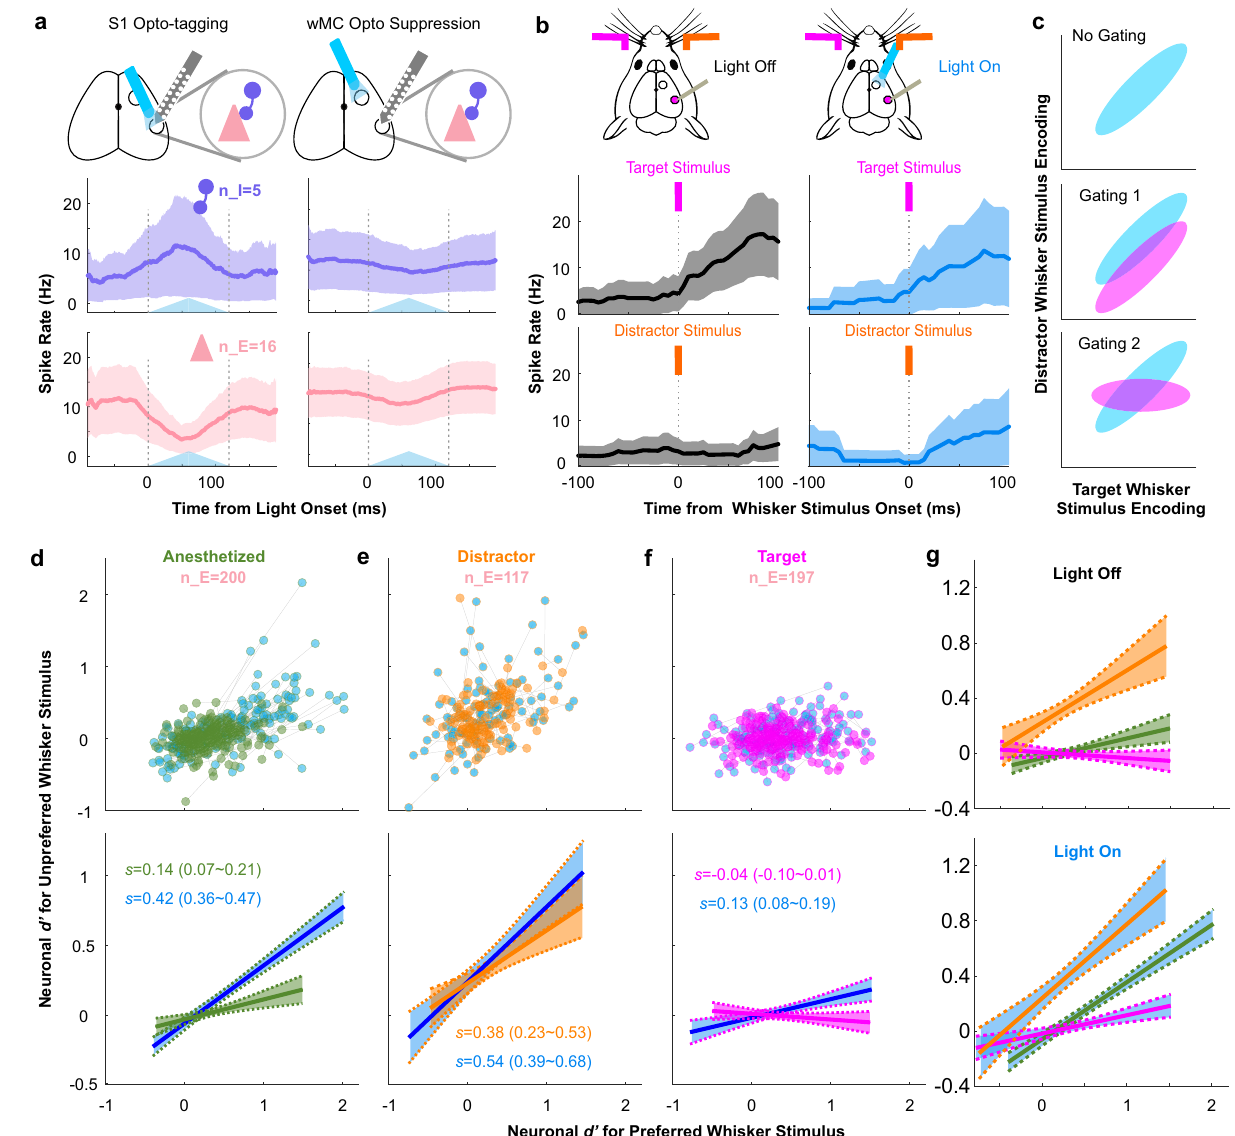
Fig.4|AsymmetricstimulusselectivityofS1singleunitsandtheirmodulation by wMC. a Example responses of S1 putative excitatory (pink) and inhibitory (purple) neurons to S1 opto-tagging (left) and the same neurons to wMC optogenetic suppression (right). Top row: for S1 opto-tagging, a light fi ber is positioned above the S1 recording probe. For wMC suppression, asecond light fi ber is positioned above wMC. Middle and bottom plots: average spiking activity recorded from one example awake behaving session with recording/ suppressionofthedistractor-alignedhemisphere.Thebluetrianglesre fl ectthe time course of opto-stimulation. b Target and distractor whisker stimulus evoked responses of an example putative excitatory neuron in target-aligned S1.Left:light-offcontroltrials;right:light-onwMCsuppressiontrials.For[a,b], data are represented as mean± SEM. c Illustration of potential mechanisms of distractor whisker stimulus gating plotted in stimulus selectivity space, with targetwhisker stimulus encodingonthe x-axis and distractor whiskerstimulus encodingonthey-axis.Bluedistributionsre fl ectapopulationoftarget-aligned